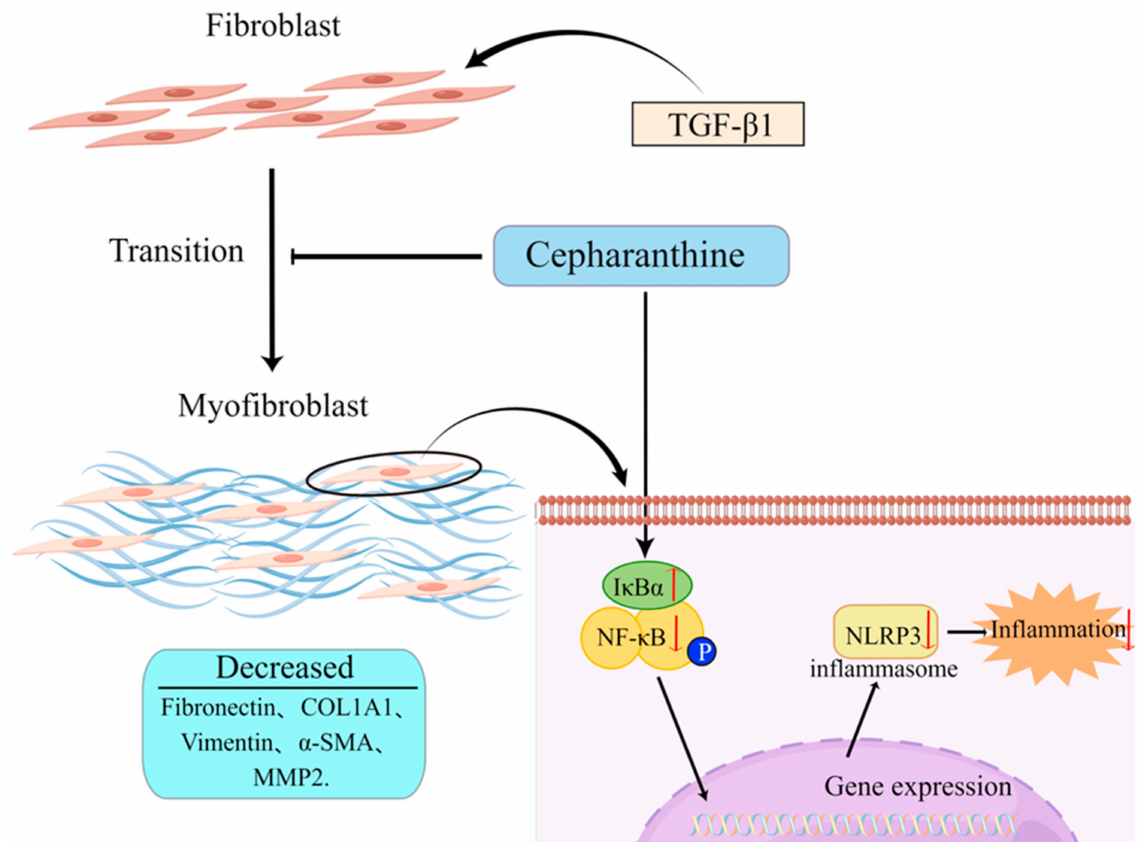
Figure 5. Schematic of the hypothesis of this study (by Figdraw). CEP suppressed inflammation and FMT in TGF- β 1-induced PF via the NF- κ B/NLRP3 signaling